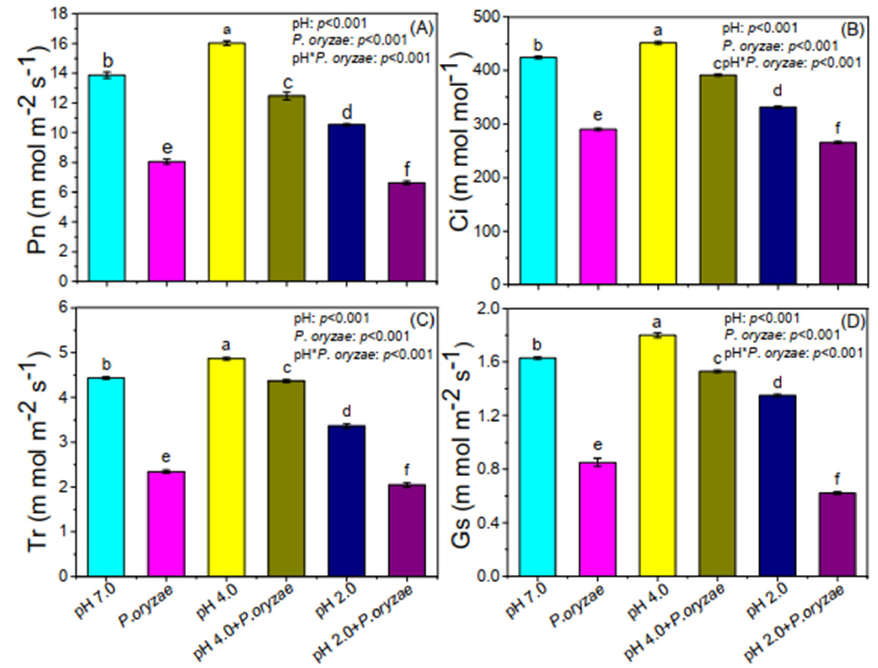
Figure 1. Effects of SAR and P. oryzae on the photosynthetic parameters of Pn ( A ), Ci ( B ), Tr ( C ), and Gs ( D ) in rice seedlings. Different lowercase letters indicate the significant difference between groups ( p < 0.05). Values are the average ± standard error ( n = 9).